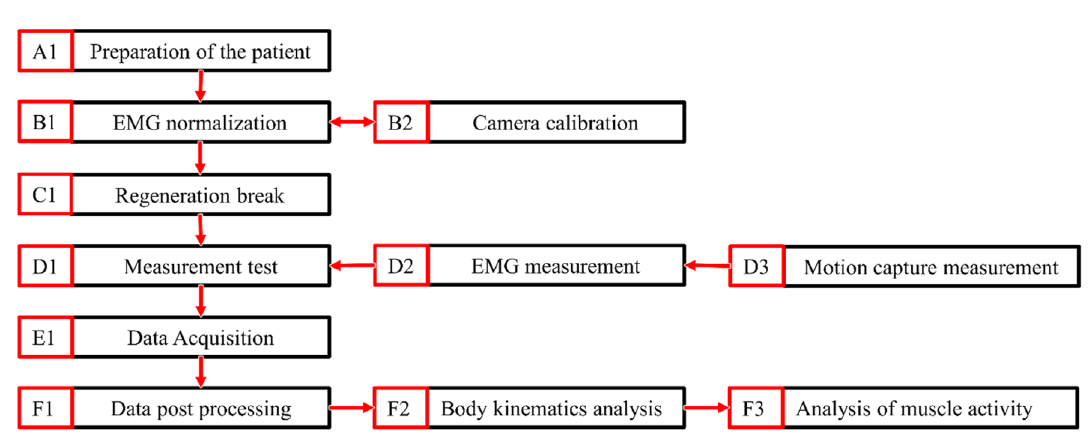
Figure 5. Block diagram of the performed measurement